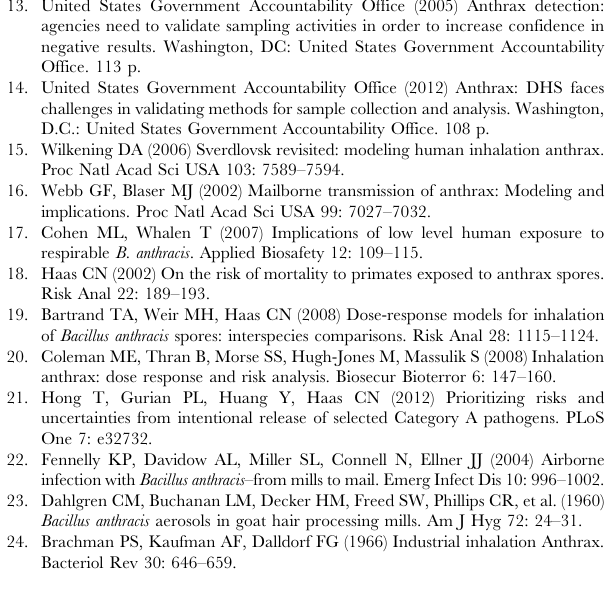
Figure S1 Sensitivity plots for model B4. In all plots, solid line is produced by model B4 under the assumption of ID 1 exposure. Dashed lines in A and B show sensitivity of the cumulative distribution function to changing the assumption to ID 50 exposure and to assuming h =0.11 instead of h =0.07. C and D show sensitivity of the probability density function to the same changes. Points in A and B and histogram in C and D are from autopsy- confirmed anthrax deaths after the Sverdlovsk release (see main text). Table S1 Non-human primate inhalational anthrax dose-response data from Druett et al. [ 27 ] . We calculate doses above as the product of the following values reported in [27]: air concentration of exposure (spores per L), breathing rate of